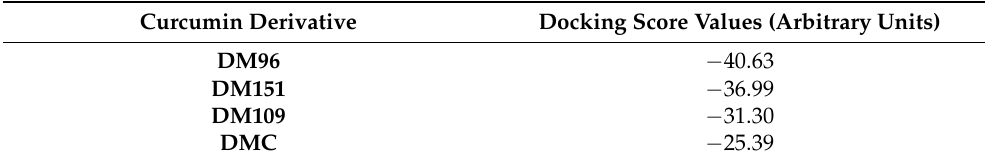
Table 4. Docking score values of the best-scored hGSTP1-1-curcumin analogur complexes obtained with the CANDOCK algorithm in conjunction with scoring function